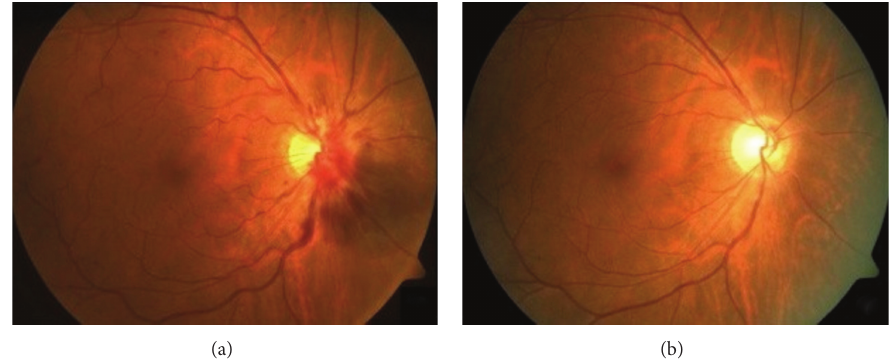
Figure 1: (a) Intraretinal hemorrhages over a right swollen optic disc associated with peripapillary hemorrhages, an area of subretinal hemorrhage inferonasally and venous tortuosity consistent with CRVO. (b) Spontaneous resolution of right optic disc swelling, peripapillary subretinal hemorrhage, and CRVO after two months.